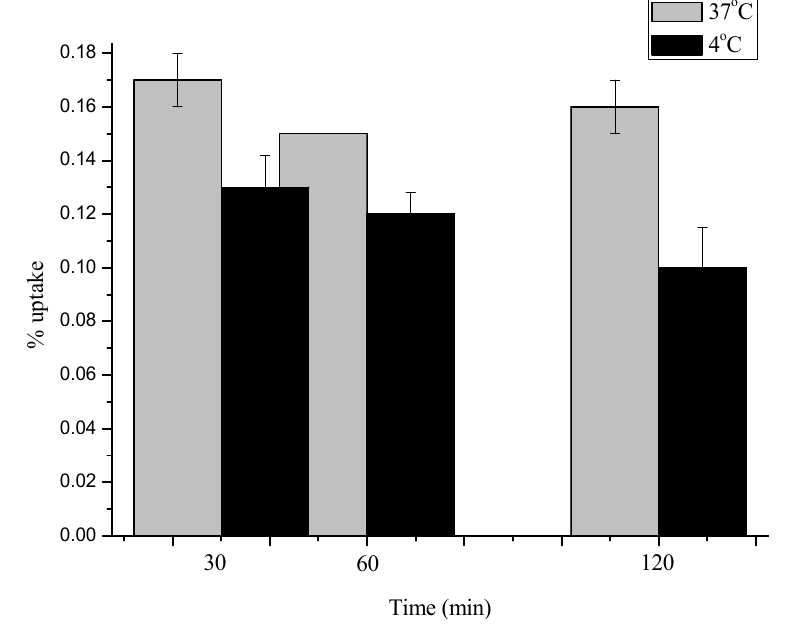
Figure 3. Comparison of uptake kinetics of [ 18 F] 3 into S180 tumor cells at 37 °C and 4 °C (pH = 7.4). Data are expressed as % uptake (mean with S.D. n = 5 each). P < 0.05.